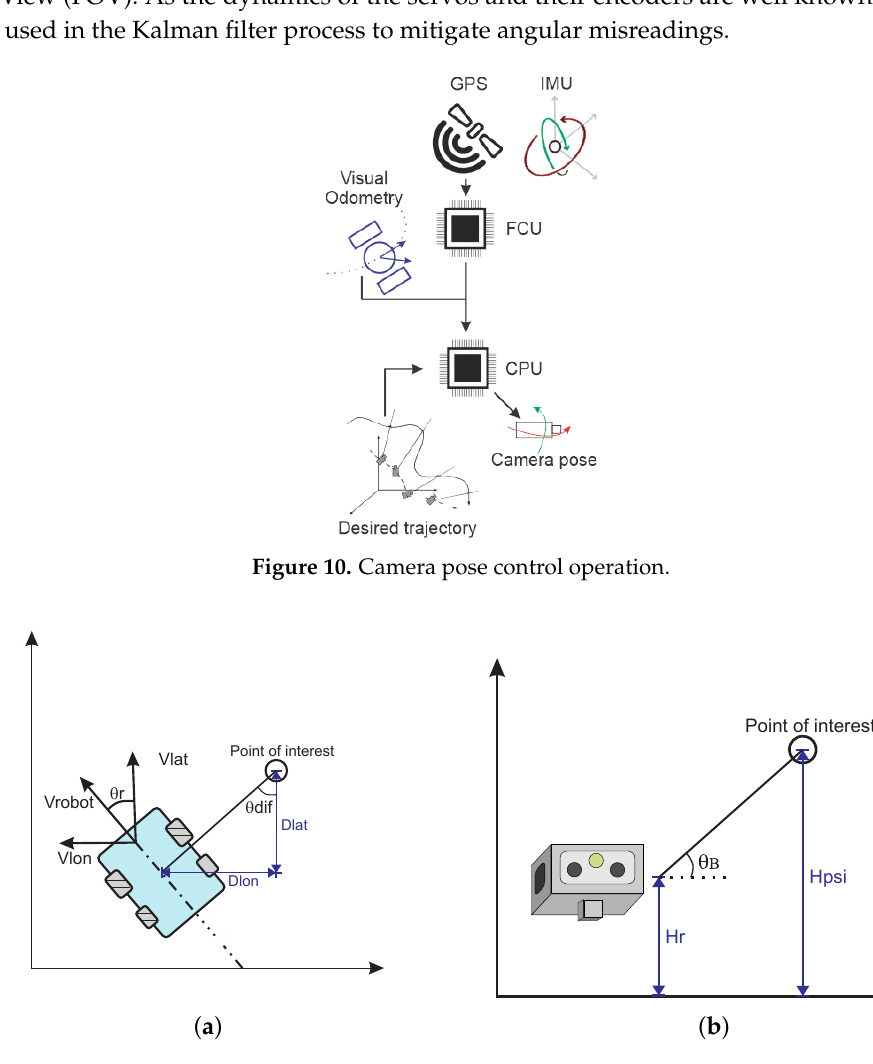
Figure 11. Automatic Orientation Scheme for the robot’s behavior when inside a Point of Interest predefined region. ( a ) Pan. ( b )